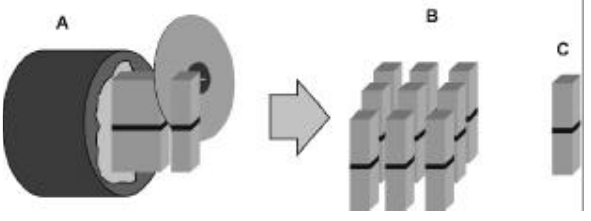
FIGURA 3 - Secção das fatias (A); CP obtidos a partir de 3 fatias (B); formato do CP (C)